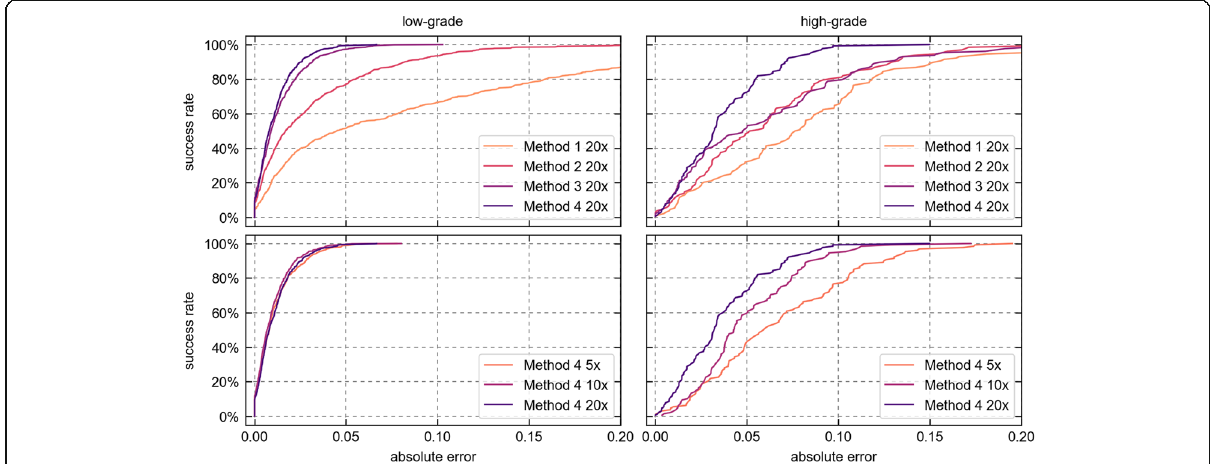
Fig. 5 Success rate curves of different analysis methods. The x-axes show absolute error levels (in area fraction), the y-axes give the corresponding percentage of images on which the absolute error was below or equal to that